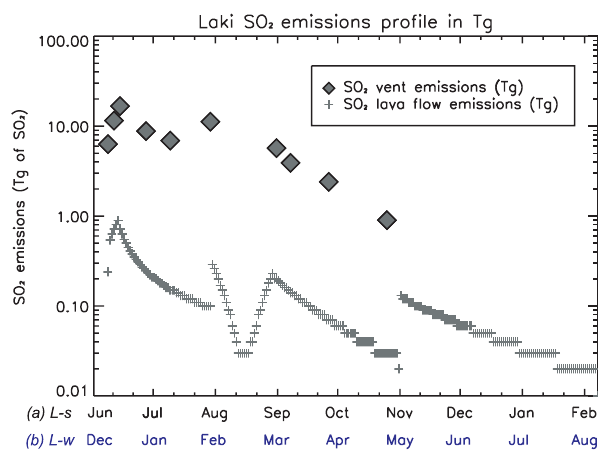
Fig. 1. Daily gas-phase SO 2 mass-loading in Tg for (a) L-s sim- ulation commencing on the 8 June and (b) for the hypothetical L-w simulation commencing on 8 December. Diamonds represent ten SO 2 mass loadings from the Laki vent system injected into the upper troposphere/lower stratosphere (i.e. between 9 and 13km) and crosses represent daily SO 2 emissions from the Laki lava flows released into the boundary layer (i.e. between surface and 1km). SO 2 mass loadings and temporal resolution for L-s are derived from Thordarson and Self (2003) with L-w employing the same mass loadings and relative temporal resolution but commencing on 8 De-